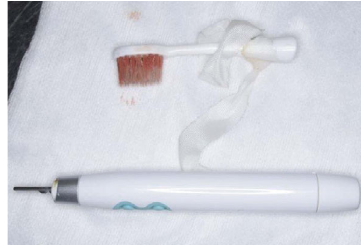
Figure 4: Case 1. The removed electric toothbrush, showing no apparent damage.